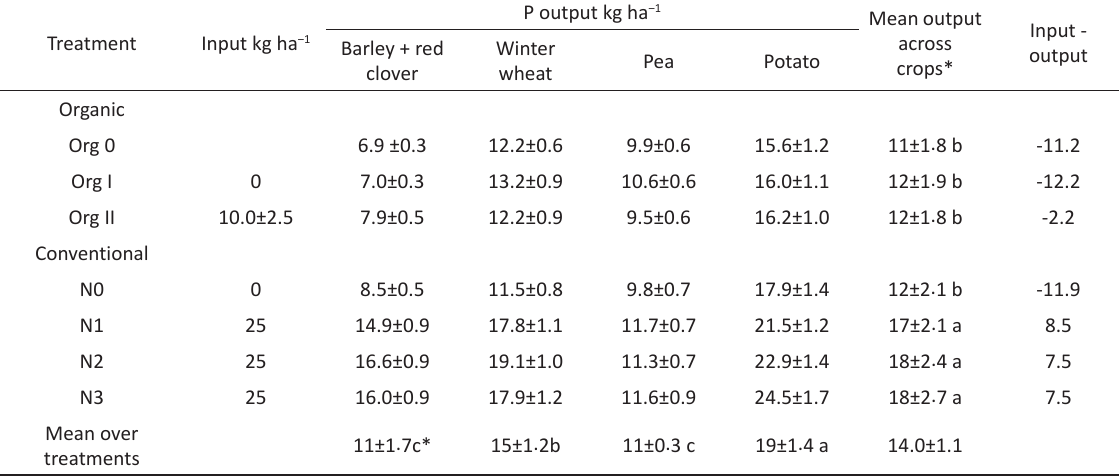
Table 4. Mean amount of P (kg ha –1 ) annually applied and removed by different crop yields from different treatments and input/ output balance in the soil as an average of ten years